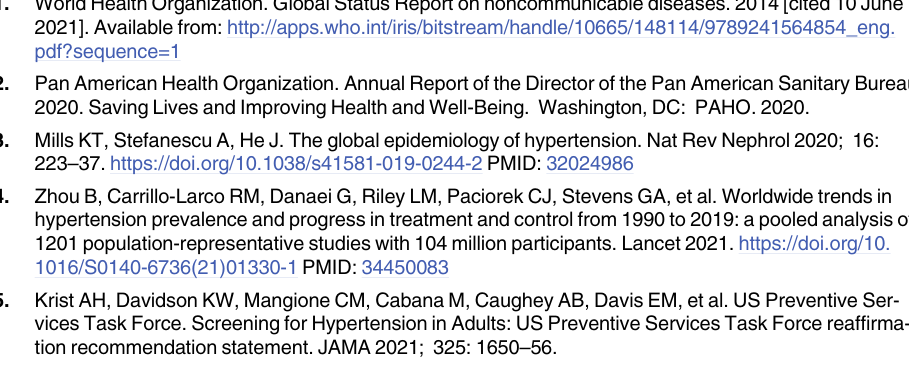
Colon using merged data from the PREFREC (2010) and ENSPA (2019) studies. Odds ratio (OR) and 95% confidence intervals (CIs). S4 Table. Crude and adjusted logistic regression analysis of hypertension unawareness (SBP/DBP � 140/90 mmHg without a self-reported medical history of hypertension) in hypertensive participants aged between 30 and 75 years in the PREFREC study in the prov- inces of Panama and Colon. Odds ratio (OR) and 95% confidence intervals (CIs). S5 Table. Crude and adjusted logistic regression analysis of hypertension unawareness (SBP/DBP � 140/90 mmHg without a self-reported medical history of hypertension) in hypertensive participants aged between 30 and 75 years in the ENSPA study in the prov- inces of Panama and Colon. Odds ratio (OR) and 95% confidence intervals